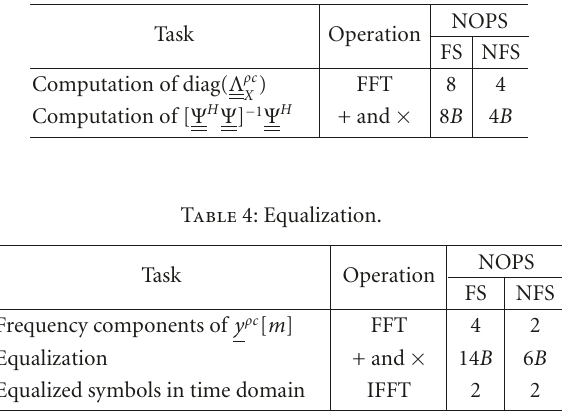
Table 3: Equalizer computation.